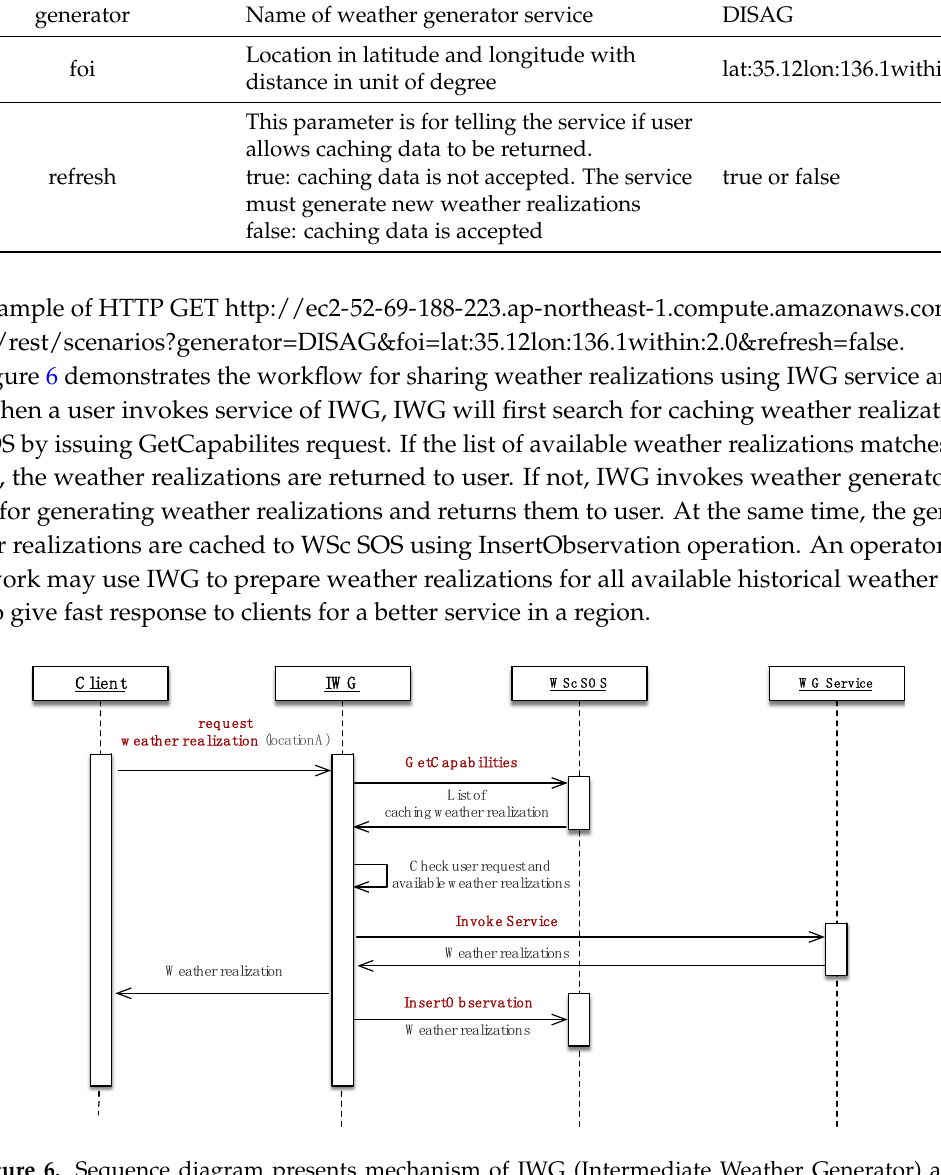
Figure 6. Sequence diagram presents mechanism of IWG (Intermediate Weather Generator) and data flow.